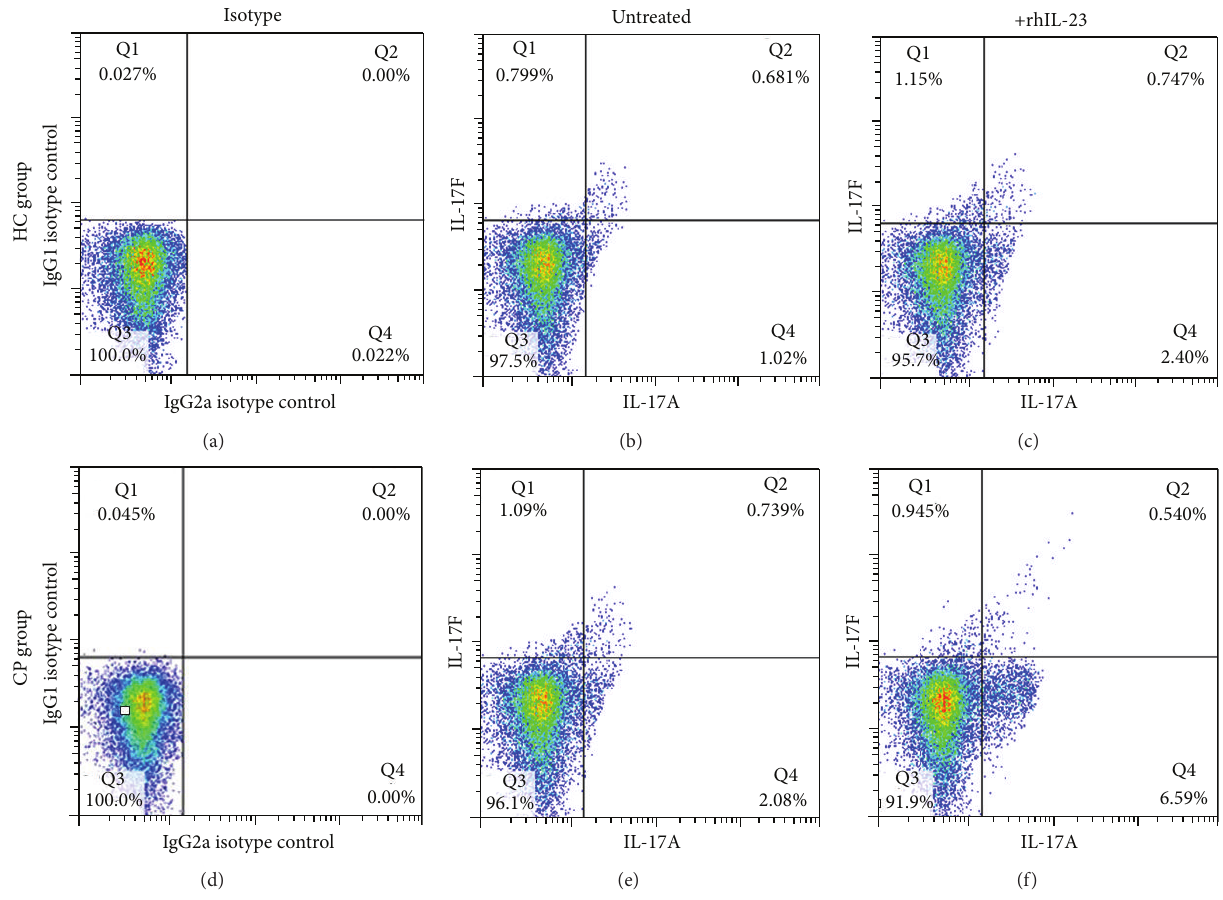
Figure 4: Expression level of (IL-17A + and/or IL-17F + ) Th17 cells in CP and HC groups with or without recombinant IL-23 stimulation. (a) and (d) showed the isotype control performed by Simultest IgG2a/IgG1, while (b), (c), (d), and (e) showed the double staining performed by IL-17A and IL-17F anti-human antibody ((c) and (f) groups were treated by rhIL-23, while (b) and (e) were not). HC group includes (a), (b), and (c); CP group includes (d), (e), and